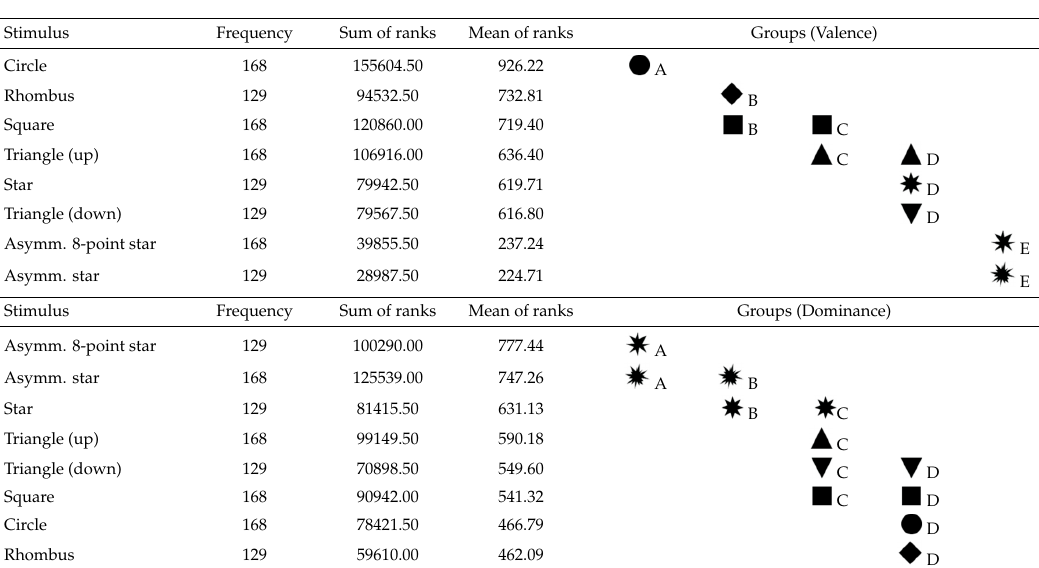
Table 2. Results of multiple pairwise comparisons of shape stimuli indicating groups of similar valence and dominance.